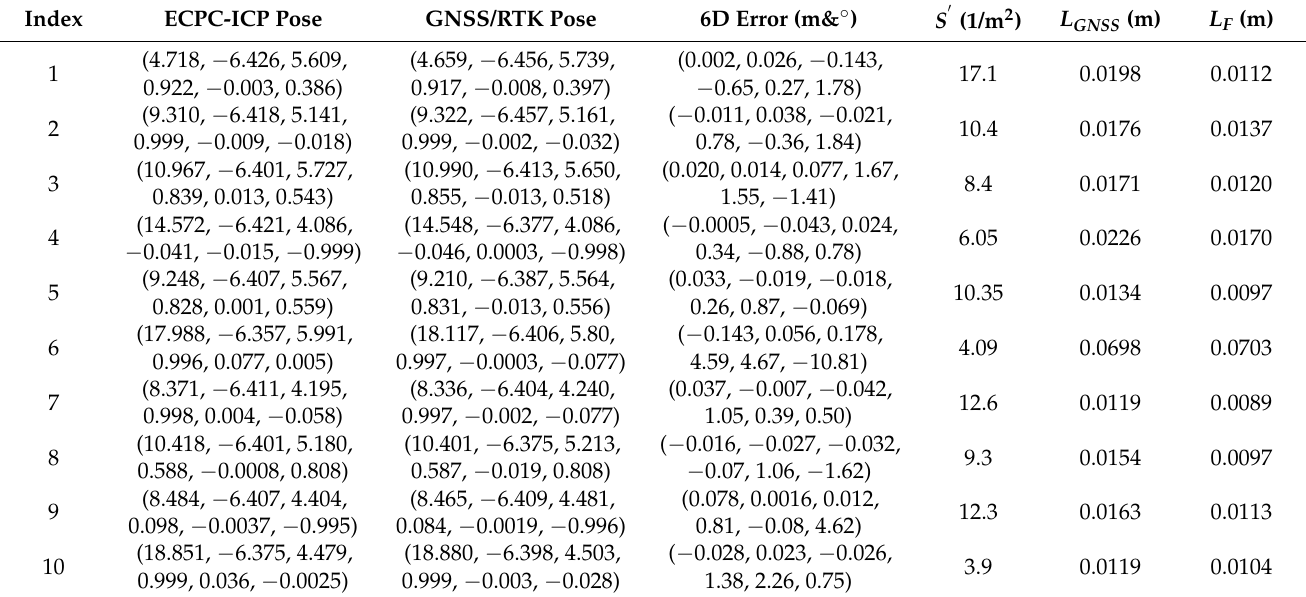
Table 4. The comparison results of ECPC-ICP pose and GNSS/RTK reference